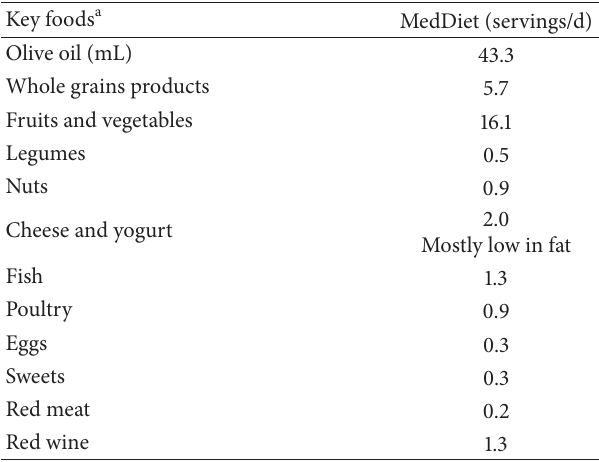
Table 1: Servings of key foods of the Mediterranean pyramid consumed daily during the experimental Mediterranean diet phase for a 10460 kJ/d (2500 kcal/d)